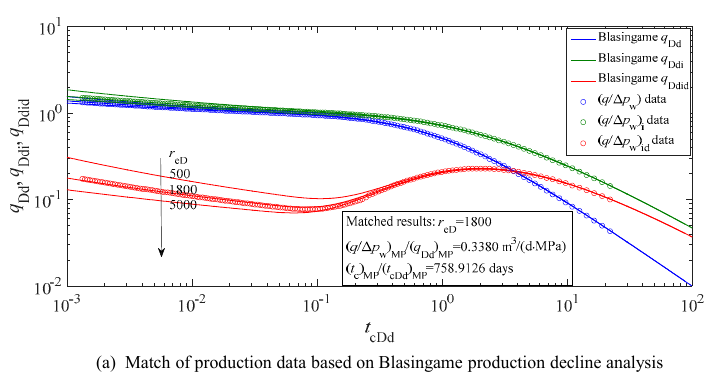
Figure 25. Match of production data for Case 2.